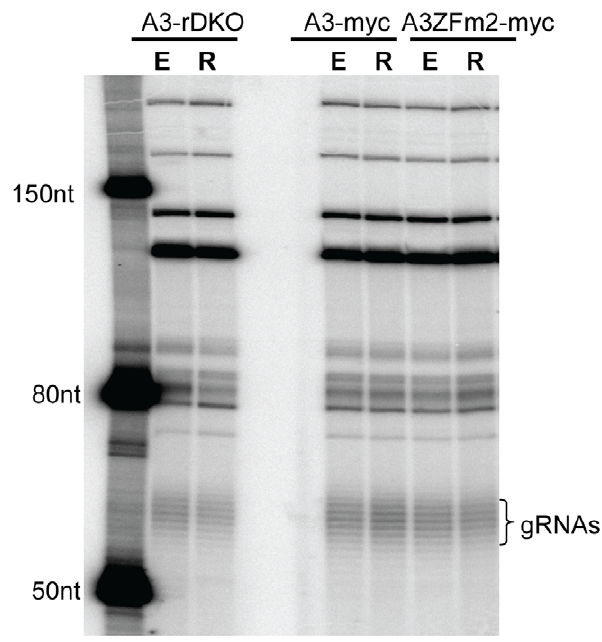
Figure 6. Loss of KREPA3 or mutation of KREPA3 ZF2 has no effect on gRNA levels. Total cellular RNA from KREPA3-RKO, RKO- KREPA3 WT-myc and ZFm2-myc cells with KREP3 Reg expressed (E) or repressed (R) were examined by a capping assay using guanylyltrans- ferse and [ a - 32 P]GTP. The similarly labeled ssRNA ladder was used to size the gRNAs which show their characteristics size heterogeneity due to their variable oligo-U tails.